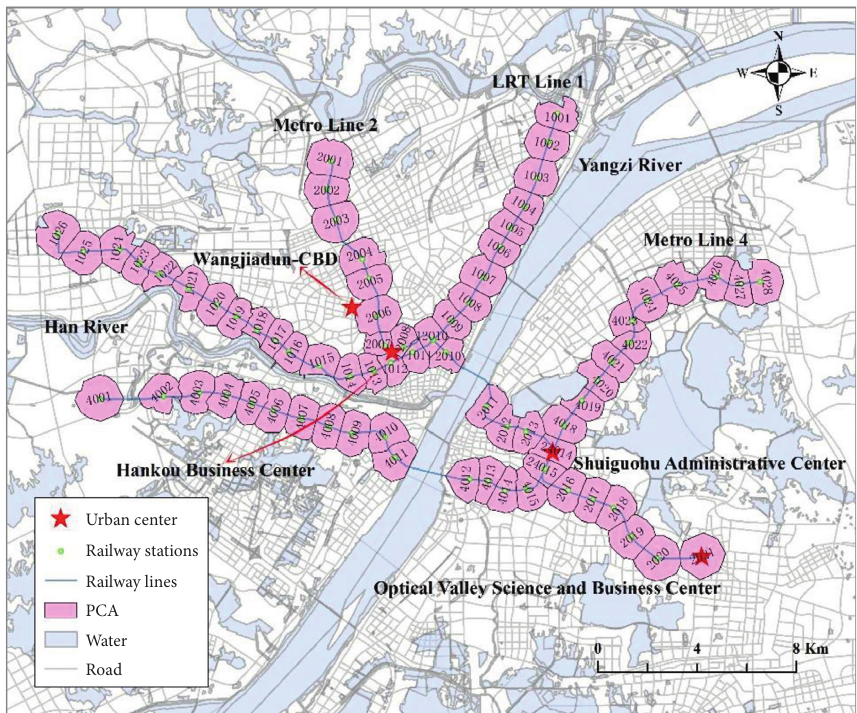
Figure 3: Study area showing the PCA of MRTstations in Wuhan. The values filled in PCA refer to the station order of rail transit lines in